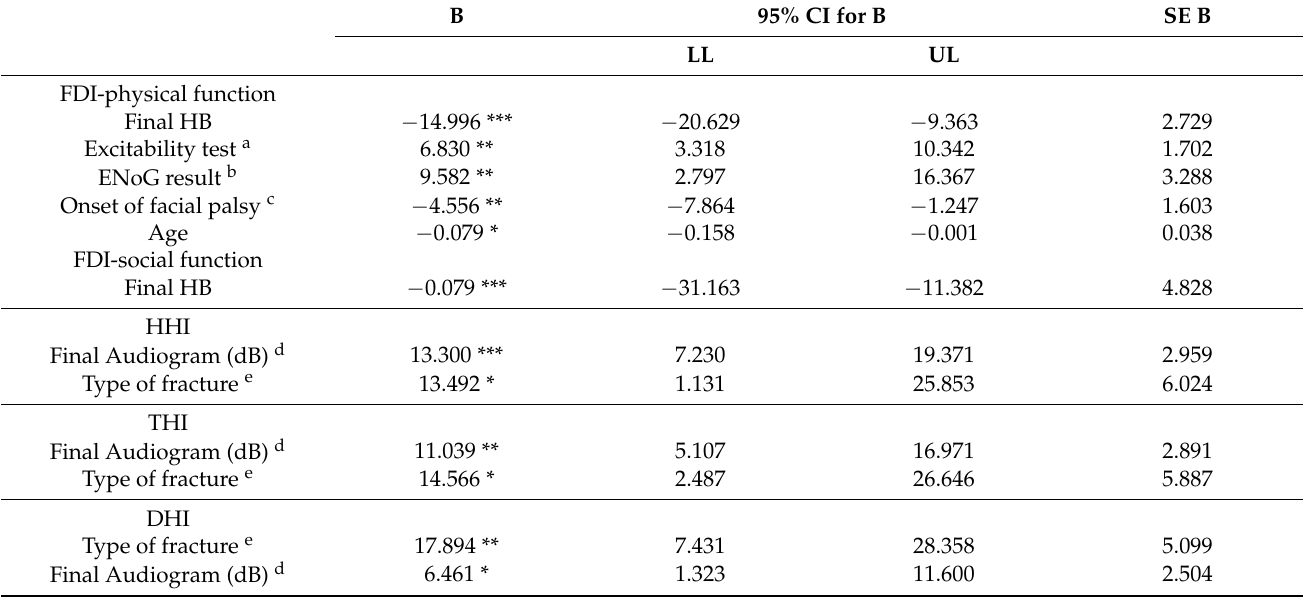
Table 5. Multiple regression results for outcome variables of facial disability index (FDI)-physical, FDI-social, hearing handicap inventory (HHI), tinnitus handicap inventory (THI), and dizziness handicap inventory (DHI). a No response-diminished-normal, b Severe-non severe, c